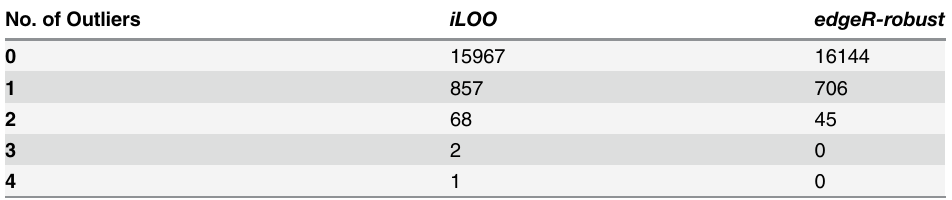
Table 1. Number of features with 0 through 4 detected outliers in the control group of rat RNA-seq data. No. of